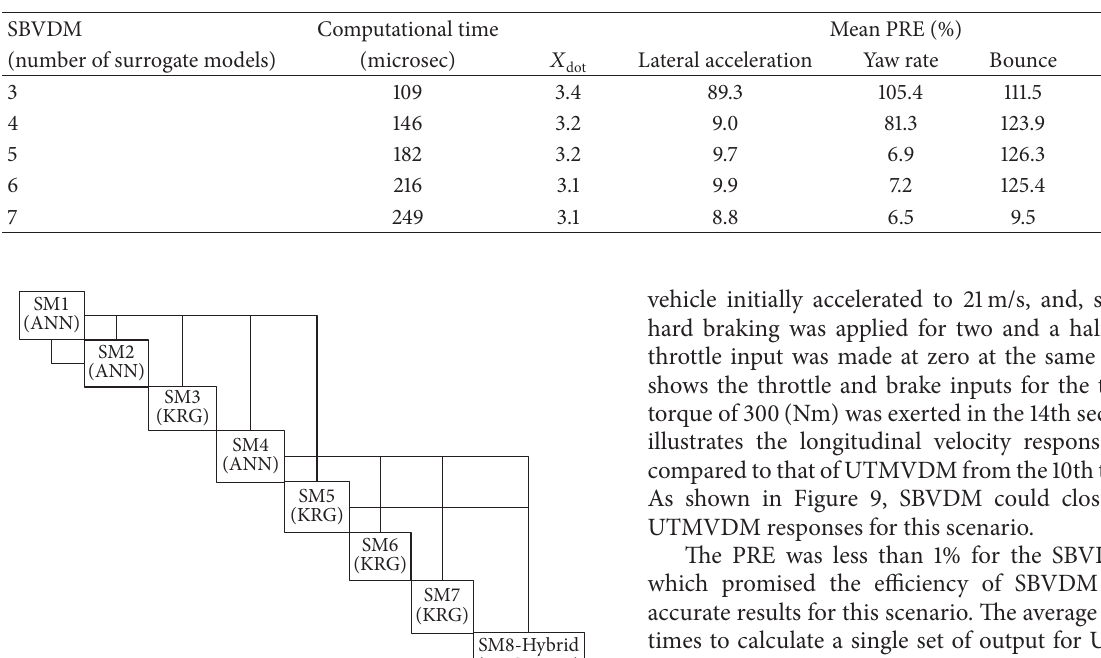
Table 3: Performance evaluation of SBVDM using different number of SMs.